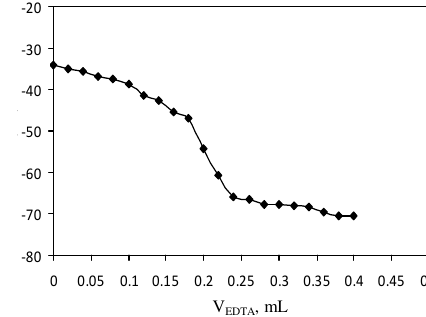
Figure 4. Dynamic response time of the gadolinium electrode for step changes in the Gd 3+ concentration: A) 1.0 × 10 -7 M, B) 1.0 × 10 -6 M, C) 1.0 × 10 -5 M, D) 1.0 × 10 -4 M, E) 1.0 × 10 -3 M, F) 1.0 × 10 -2 M